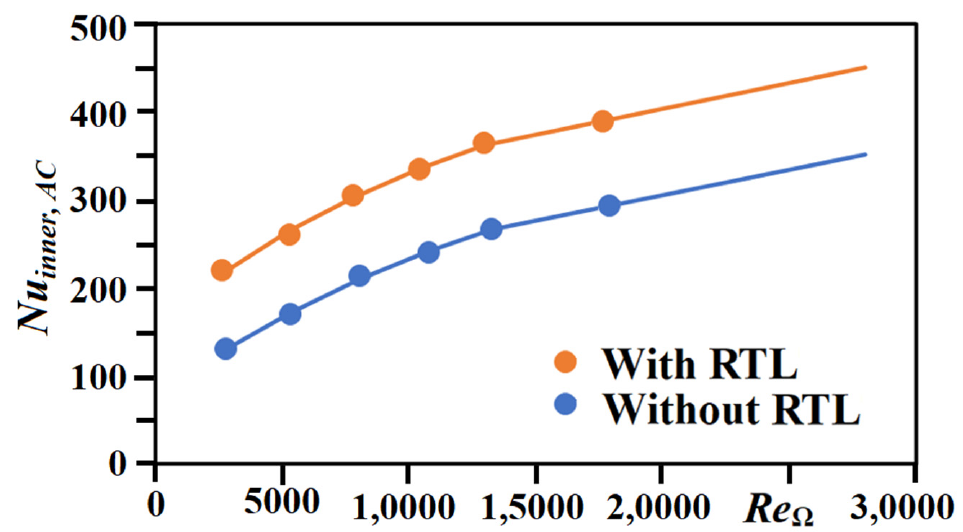
Figure 10. Variations of Nu inner,AC against Re Ω in the air chambers with and without the RTLs.